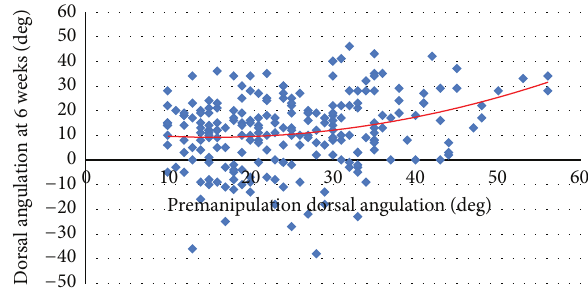
Figure 2: Correlation between premanipulation dorsal angulation and dorsal angulation at 6 weeks.